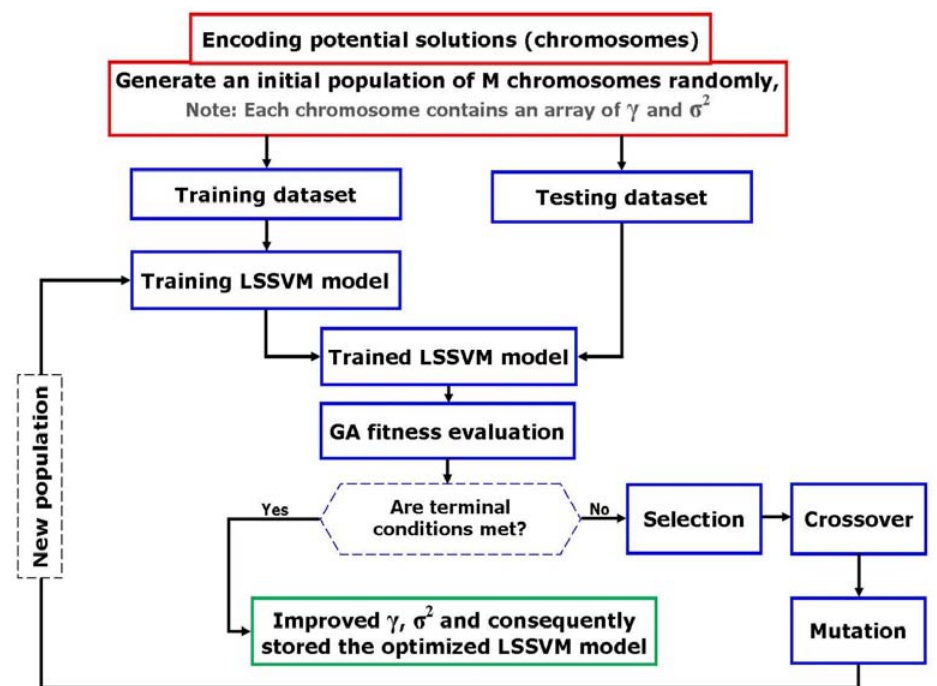
Figure 4. Flowchart of GA-based optimization algorithm to adjust the embedded parameters of LSSVM model. Table 2. Basic parameter values of GA ‐ LSSVM model for the prediction of viscosity and thermal conductivity of (cid:1832)(cid:1857) (cid:2870) (cid:1841) (cid:2871) /ethylene glycol ‐ water nanofluid. Type